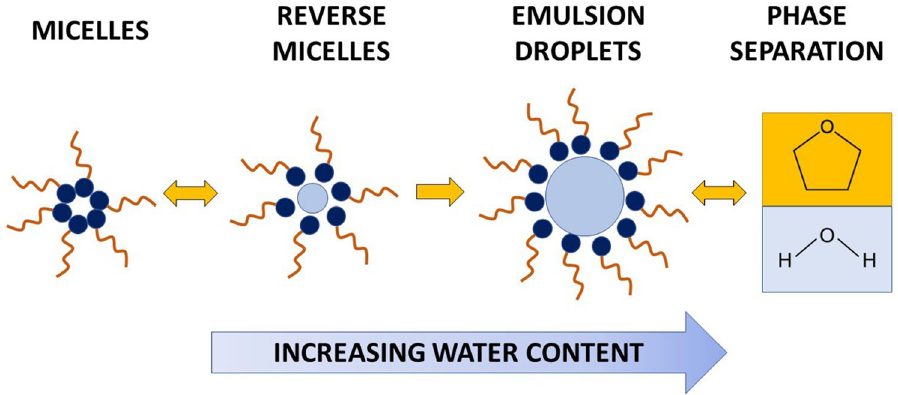
Figure 4. Proposed mechanism of THF-water separation by lauric acid. Note that this mechanism occurred when mixing lauric acid in its dry form to THF-water mixtures. Mixing dry lauric acid in water is an option when treating surface water. Delivery of lauric acid in polluted aquifers requires that its is dissolved in a liquid carrier, e.g., canola oil, as discussed later and schematized in Fig.